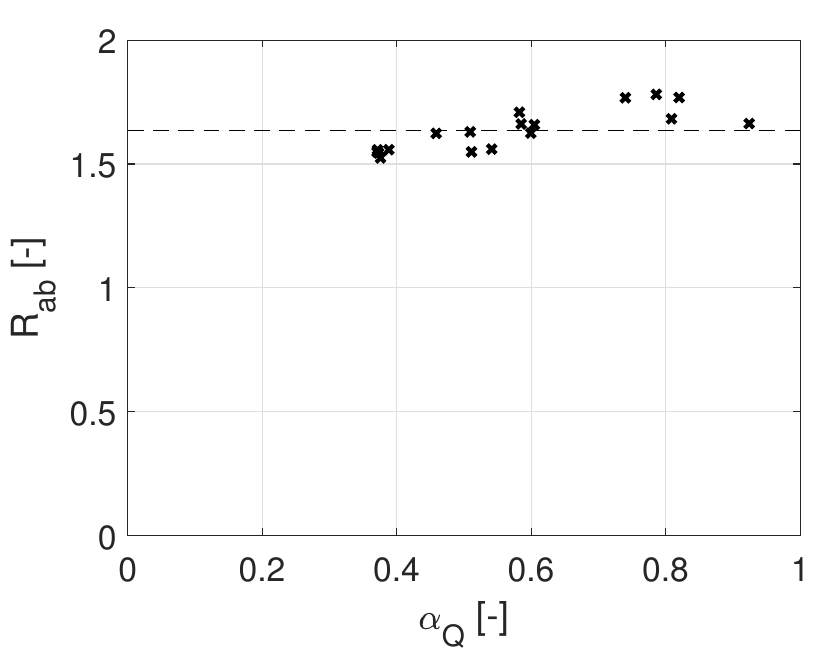
Figure 9. Jump ratio R ab as a function of the conversion α Q . The values lie within 10% of the mean (dashed line) value